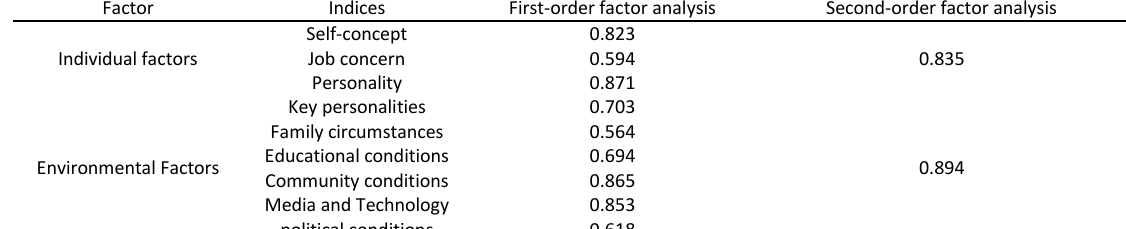
Fig. 1: First and second order factor analysis